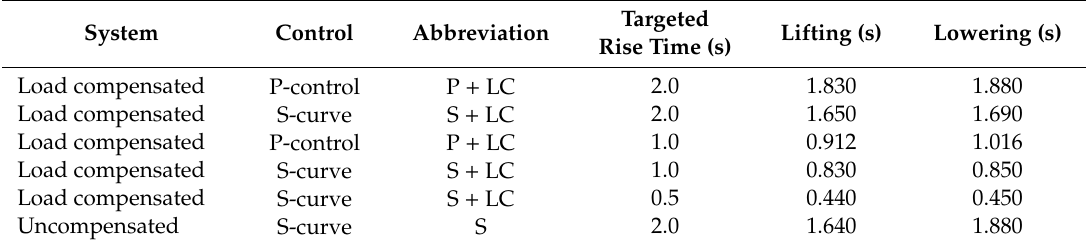
Table 3. Targeted nominal stroke times and actual stroke